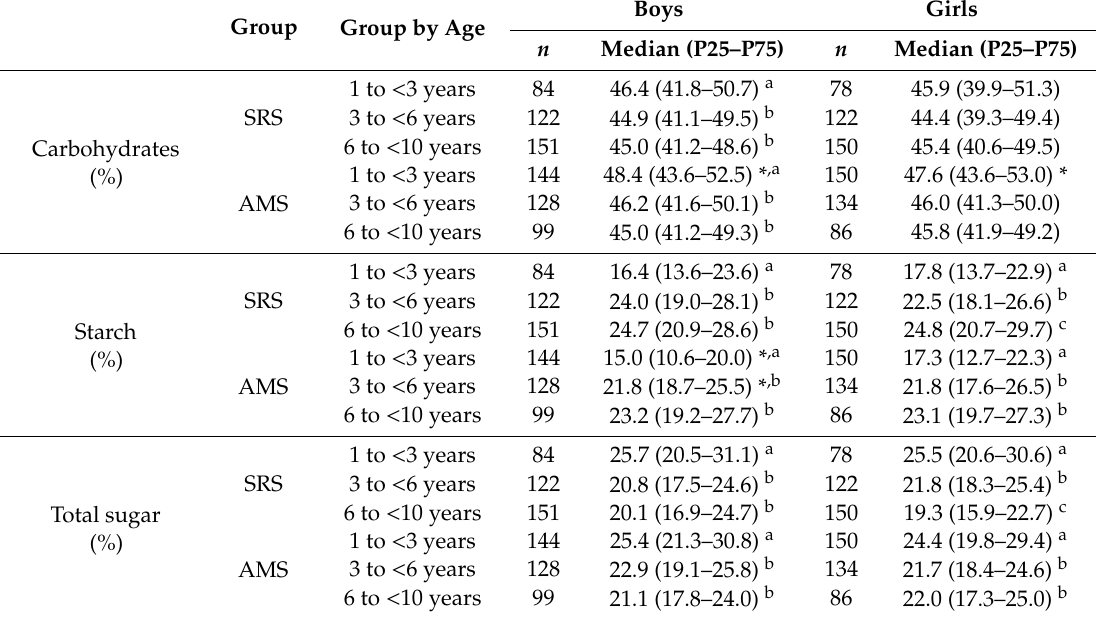
Table 3. Total carbohydrates, starch, and total sugar distribution (% of total energy) in the Spanish Pediatric Population (EsNuPI) study in both Spanish Reference Cohort, Adapted Milk Consumers Cohort.